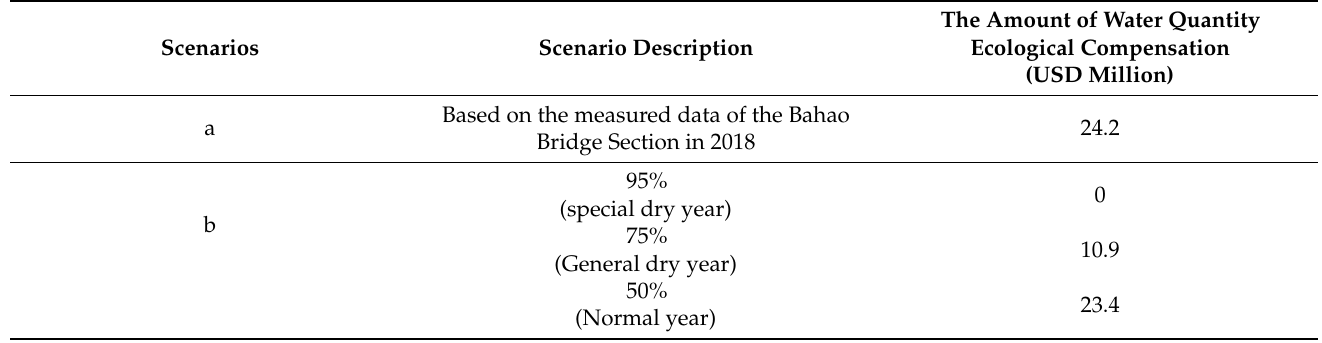
Table 7. The amount of water quantity ecological compensation based on restoration cost method under different scenarios.